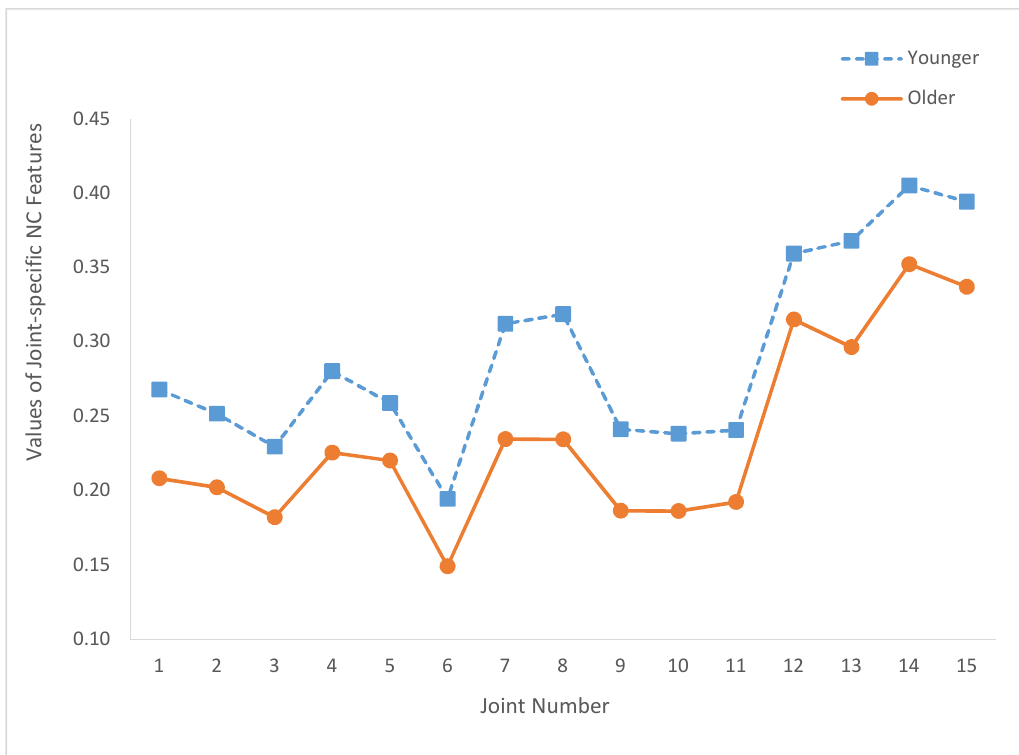
Figure 6. Summary of the joint-specific zero-crossing point (ZCP) features (JZCP i , i = 1, …, 15) for both age groups.